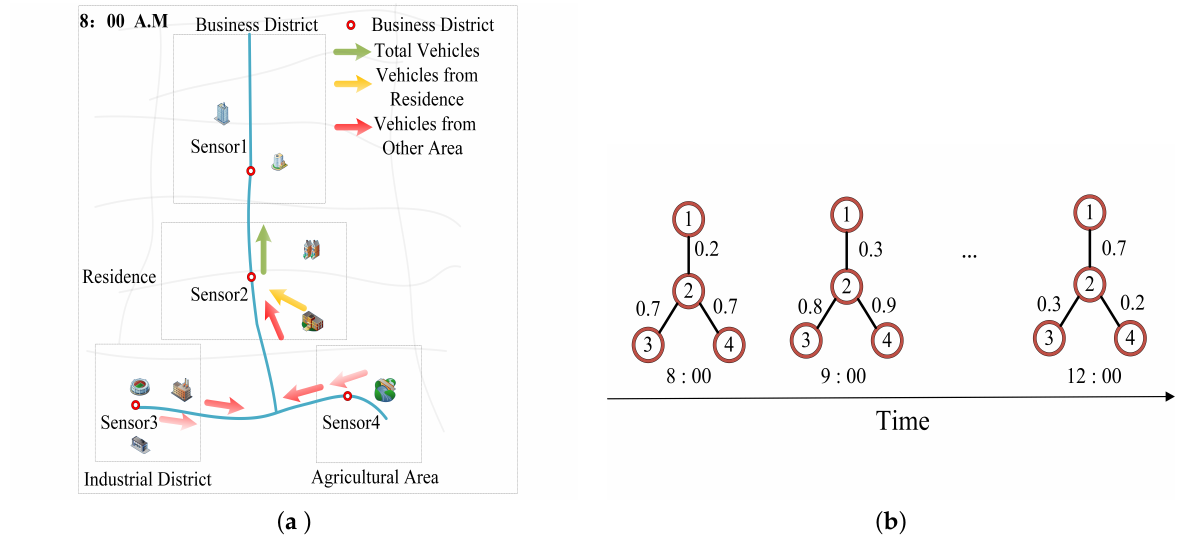
Figure 1. An example of the traffic flow system; ( a ) An example of the traffic flow system in at 8:00 a.m.; ( b ) Dynamic spatial